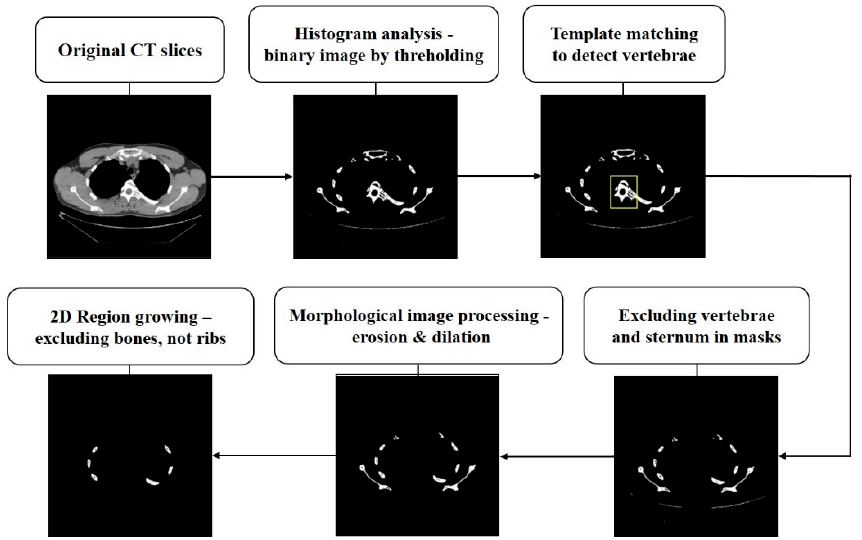
Figure 2. Results of image processing in the intensity-based image processing (IIP)-based method.